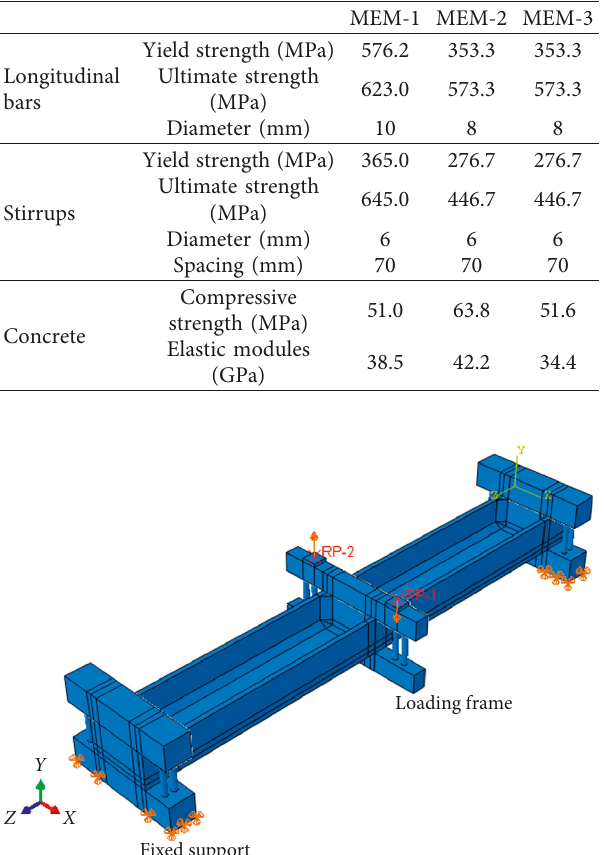
Figure 7: FE modeling of the U-shaped thin-walled RC girder under pure torsion.